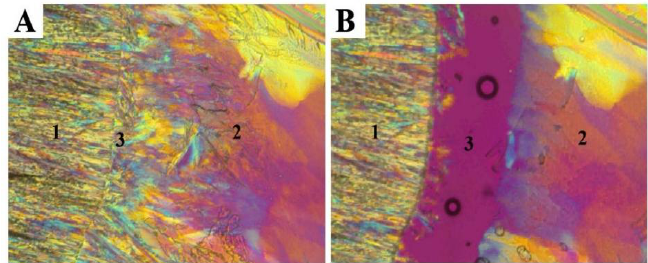
Figure 1. Observation of mixed fusion behaviour of ibuprofen and stearic acid, A. Formation of contact area, and B. First melting of contact area, (1= ibuprofen, 2= stearic acid and 3 = contact area)